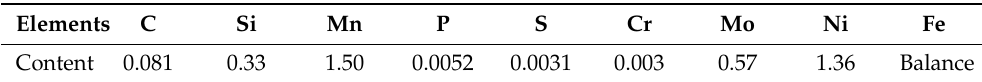
Table 1. Chemical compositions of welding wires used for preparing high-strength low-alloy steel T-branch pipe through SAAM.